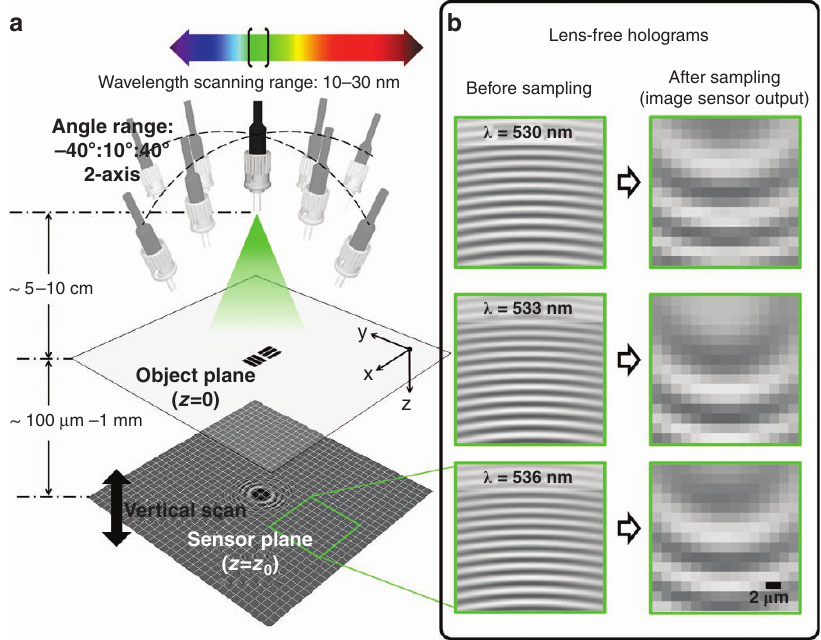
Figure 1 Optical setup of wavelength-scanning pixel-super resolution. ( a ) A lens-free holographic on-chip microscope using wavelength-scanning pixel super- resolution. A fi ber-coupled tunable light source is placed above the object. When performing pixel super-resolution, the wavelength is scanned within a spectral range of 10 – 30 nm. Multi-height and synthetic aperture imaging con fi gurations are also integrated into this setup to enable phase retrieval. ( b ) Lens- free holograms at different wavelengths before and after digital sampling at the image sensor